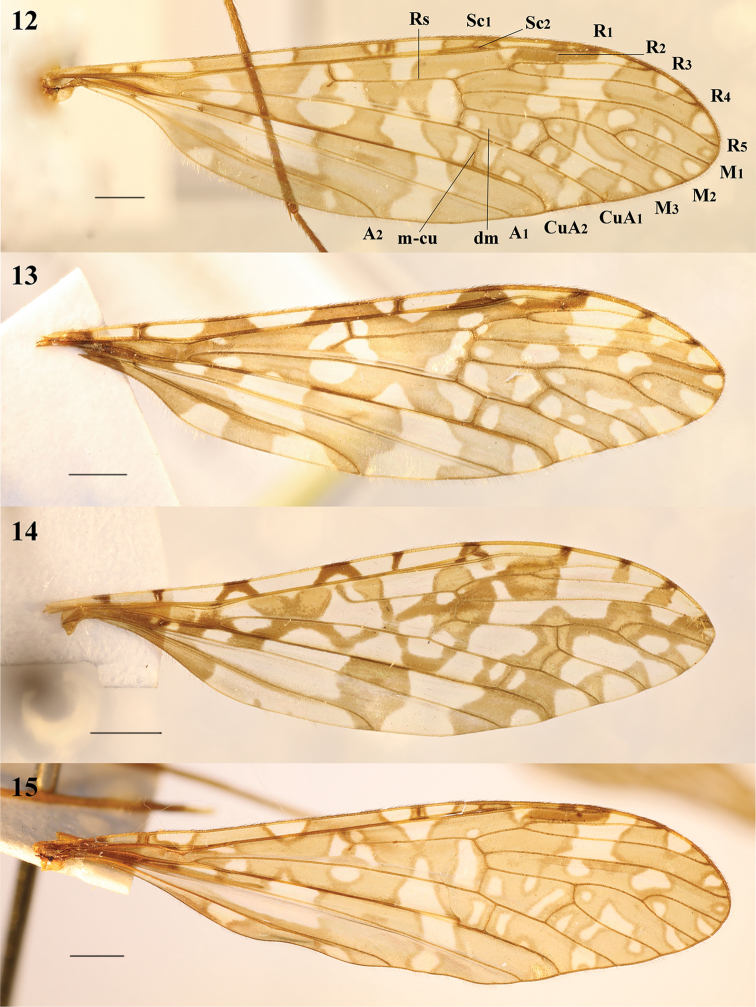
Wing (male). 12Epiphragma (Epiphragma) acuminatum sp. nov. 13Epiphragma (Epiphragma) henanensis sp. nov. 14Epiphragma (Epiphragma) insigne (van der Wulp, 1878) 15Epiphragma (Epiphragma) longitubum sp. nov. Scale bars: 1 mm.